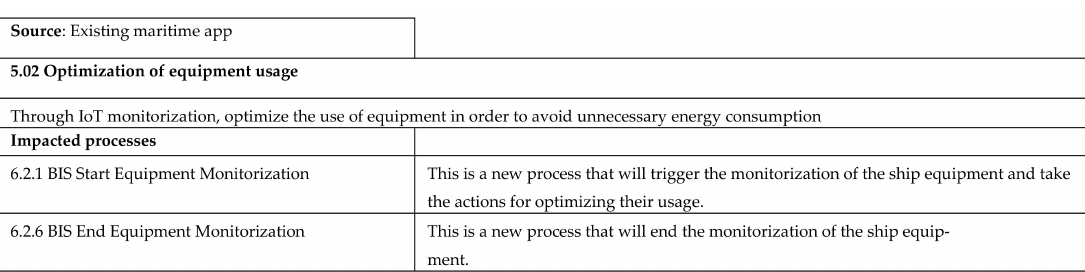
Figure A37. Cont